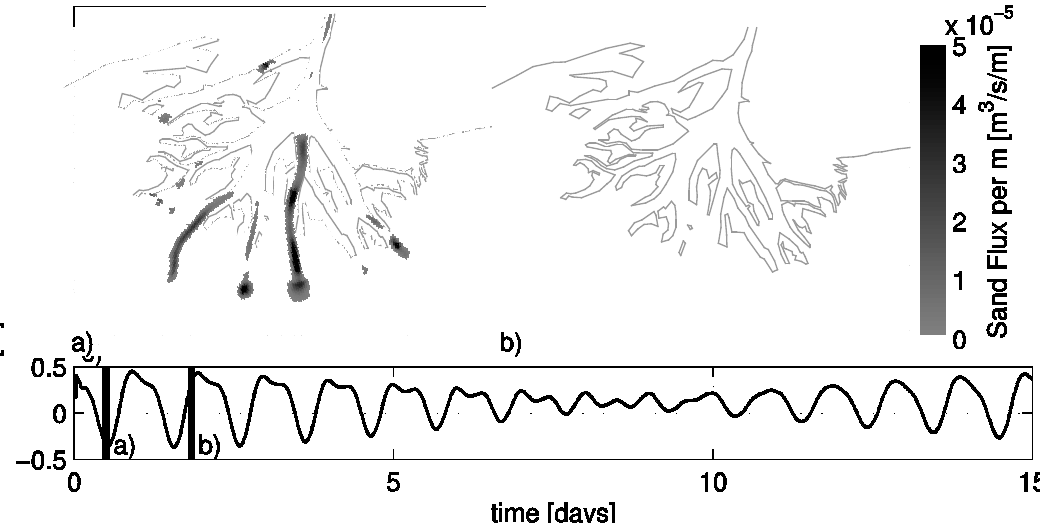
Fig. 2 Spatial distribution of sand sediment flux through WLD distributary channels at two instances during the simulation: (a) shows the sand sediment flux distribution at a low spring tide, and (b) the distribution at a rising spring tide. The position in the tidal cycle shown in (a) and (b) are denoted by the thick black lines in (c).